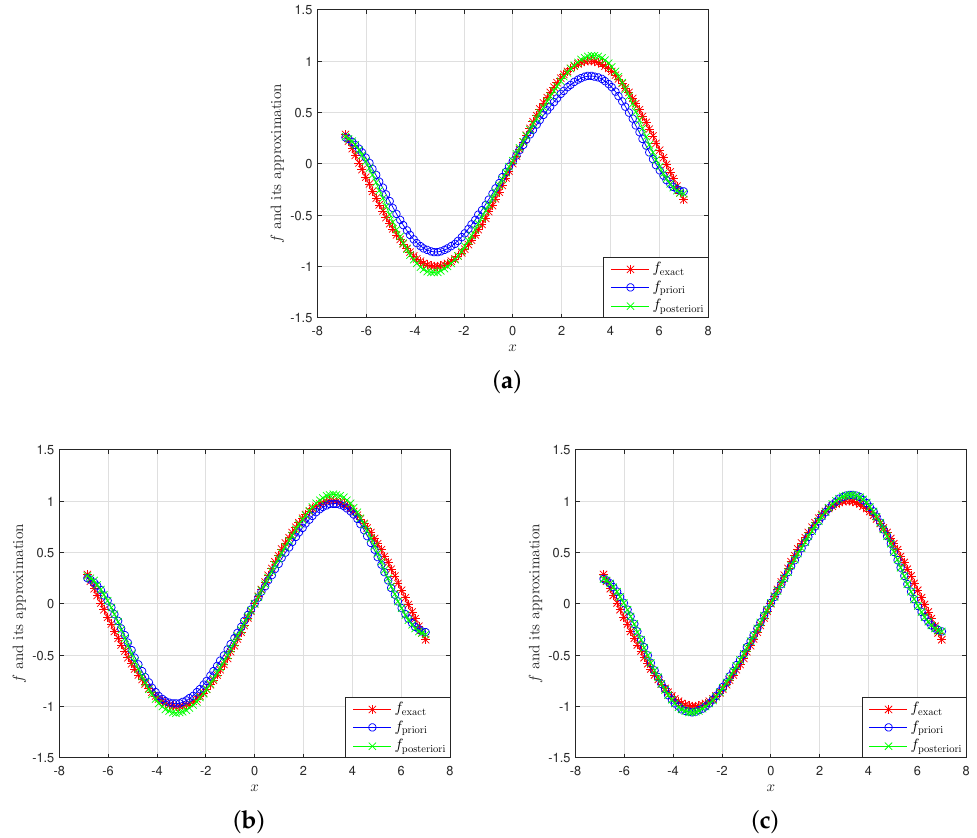
Figure 1. A comparison between the exact and regularized solutions for k = 1, β = 0.95 with N = 100. ( a ) ε = 0.1. ( b ) ε = 0.01. ( c ) ε =